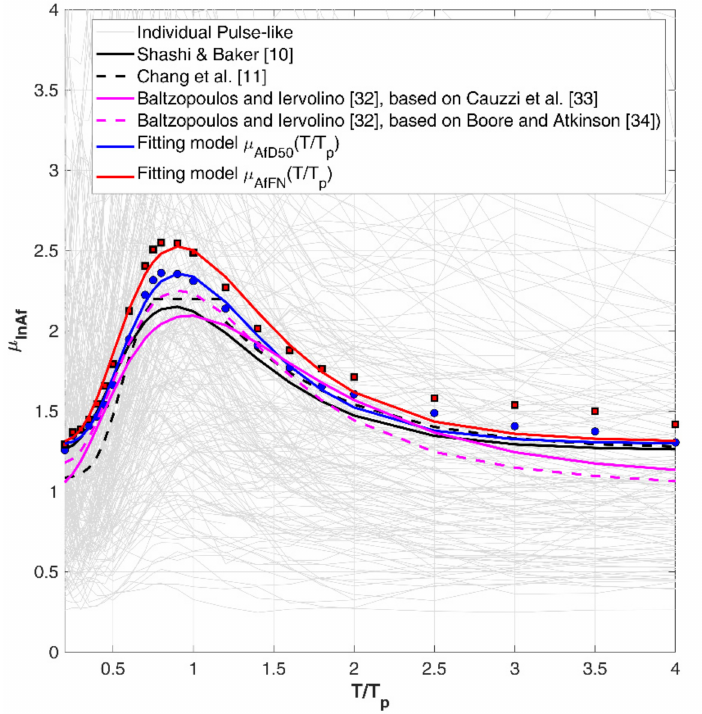
Figure 10. Amplification factor for spectral acceleration of pulse-like records compared to previous models